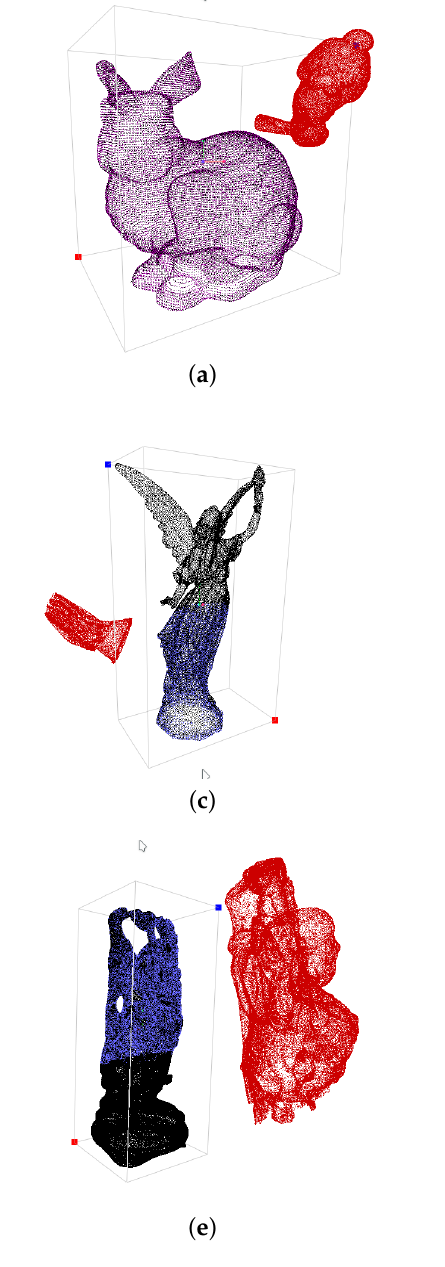
Figure 7. Various examples of combined attacks: ( a ) Affine transformation ( m p = 100%). ( b ) Affine transformation and cropping ( m p = 95.31%). ( c ) Affine transformation, cropping and random removal ( m p = 93.75%). ( d ) Affine transformation and local noise ( m p = 96.88%). ( e ) Affine transformation and cropping with slantwise cut ( m p = 87.50%). ( f ) Affine transformation and complex cropping ( m p =